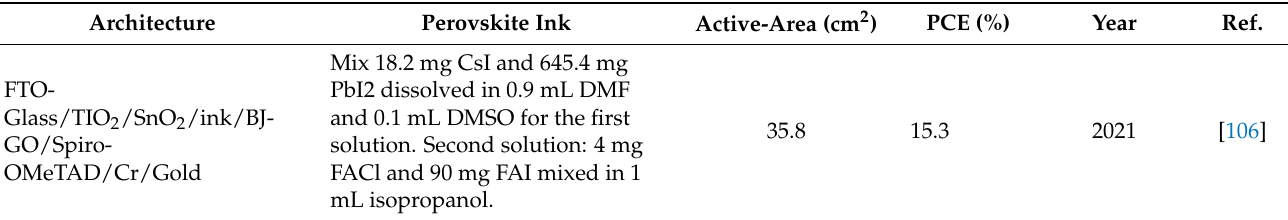
Table 6. Recently reported large-scale devices with different perovskite